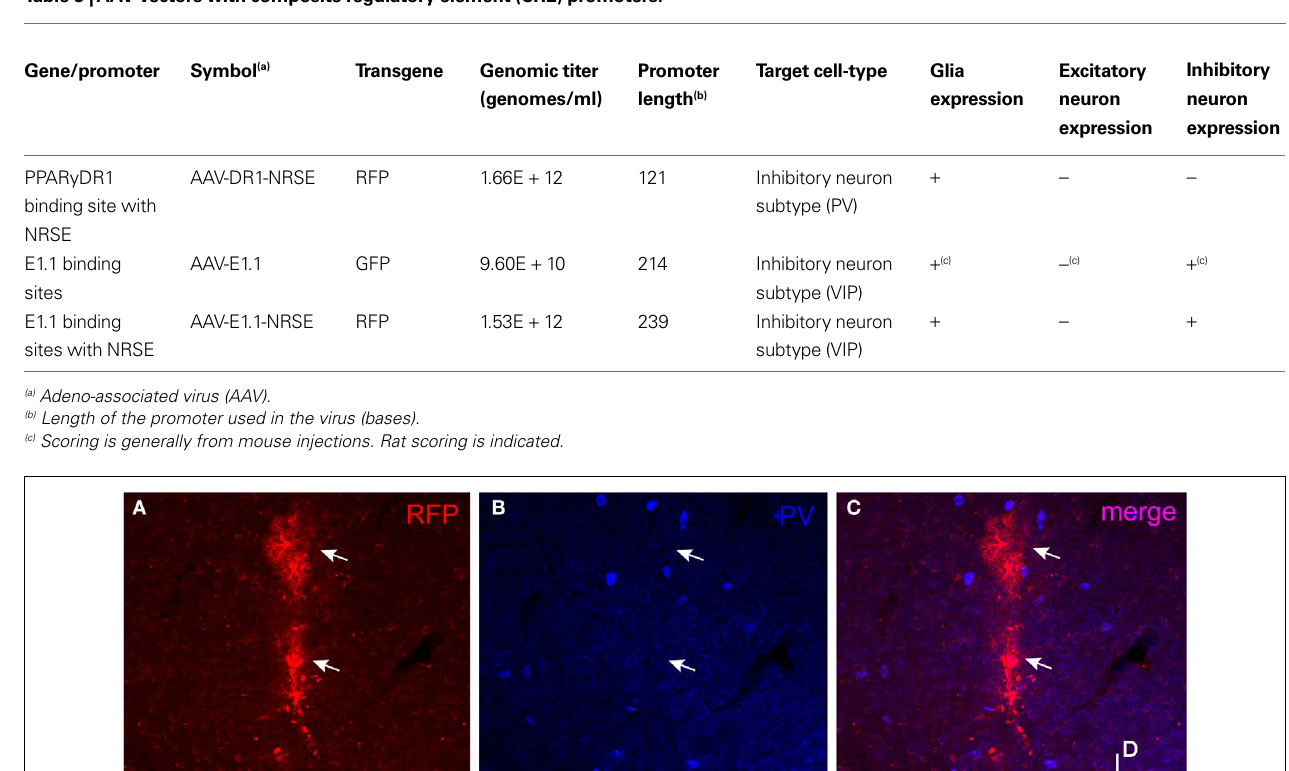
Table 3 | AAV vectors with composite regulatory element (CRE) promoters.